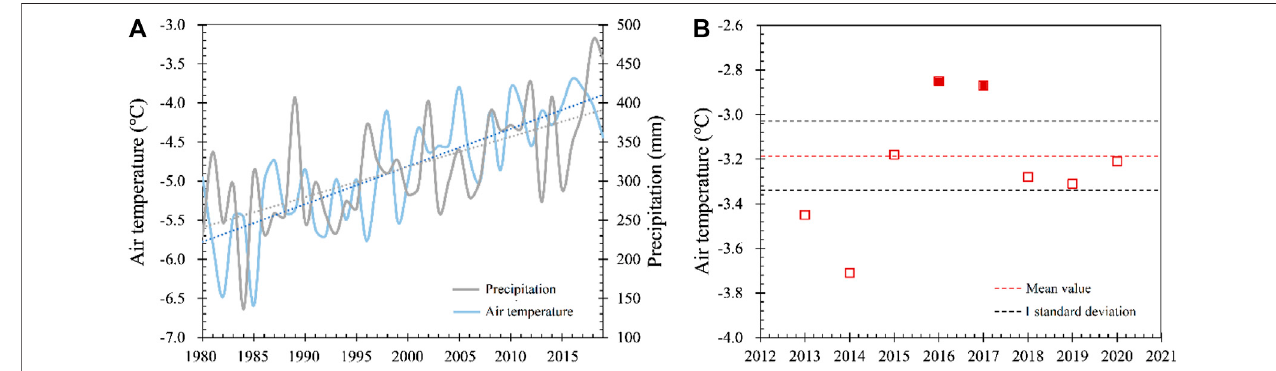
FIGURE 8 | Changes in the local climatic conditions over time. (A) Annual mean air temperature and annual accumulated precipitation at Wudaoliang national weather station from 1980 to 2019; (B) Annual mean air temperature in the Xidatan region from 2013 to